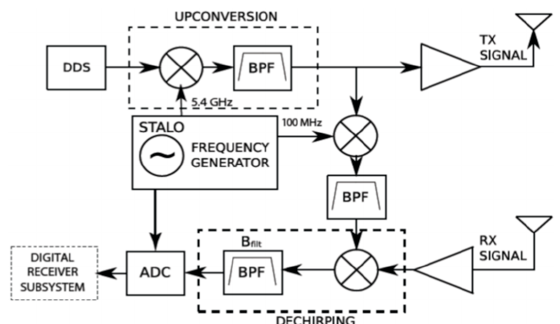
Figure 6. Radio frequency (RF) system signal flow block diagram of the microASAR [2,3]. The signal begins as a repetitive linear frequency modulation chirp generated by a direct digital synthesizer (DDS) which is mixed up and filtered by a bandpass filter (BPF). The received signal is homodyne-mixed down to an offset video signal before sampling with an analog to digital converted (ADC), which is followed by digital processing. The offset-homodyne mixing simplifies processing and minimizes ADC quantization noise